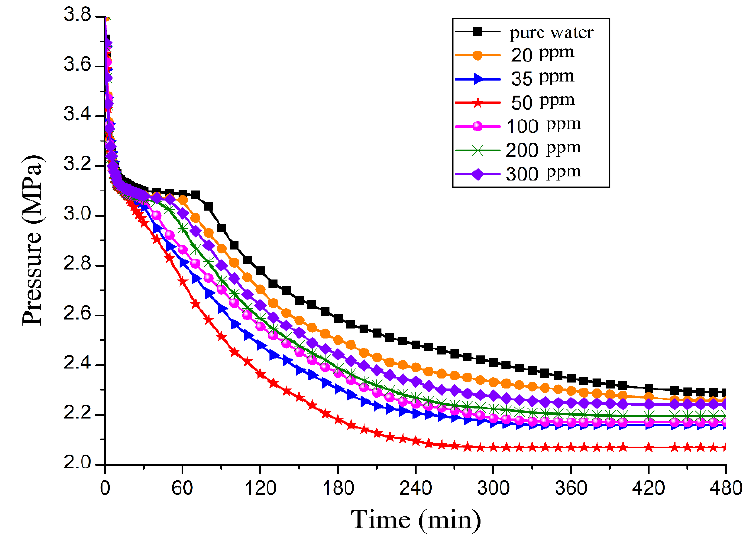
Figure 7. Pressure change curves of CO 2 hydrate formation in the different concentrations of GO.